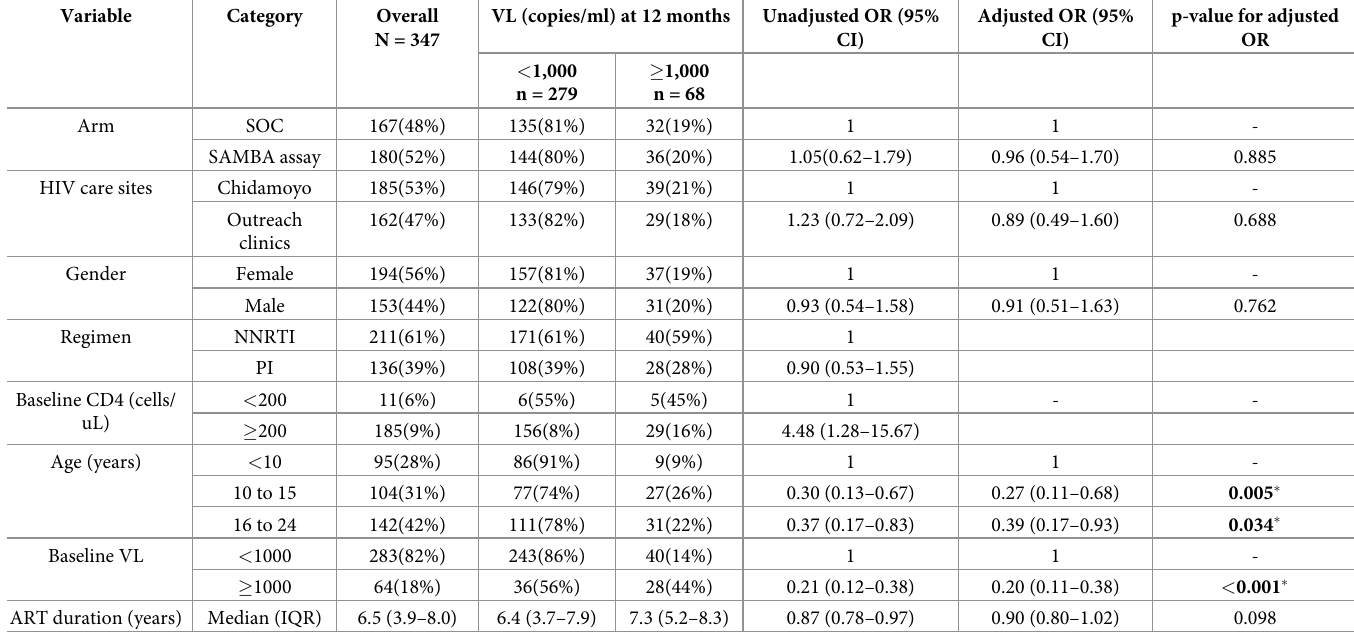
Table 3. Characteristics associated with viral load suppression at 12 months.